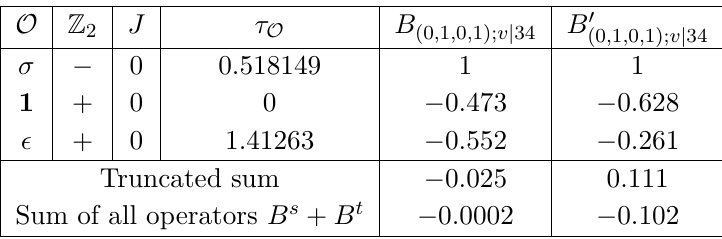
Figure 12 . Close-up of the action of B the leading 2∆ (grey vertical dotted line) and subleading 2∆ (cid:15) double-twist